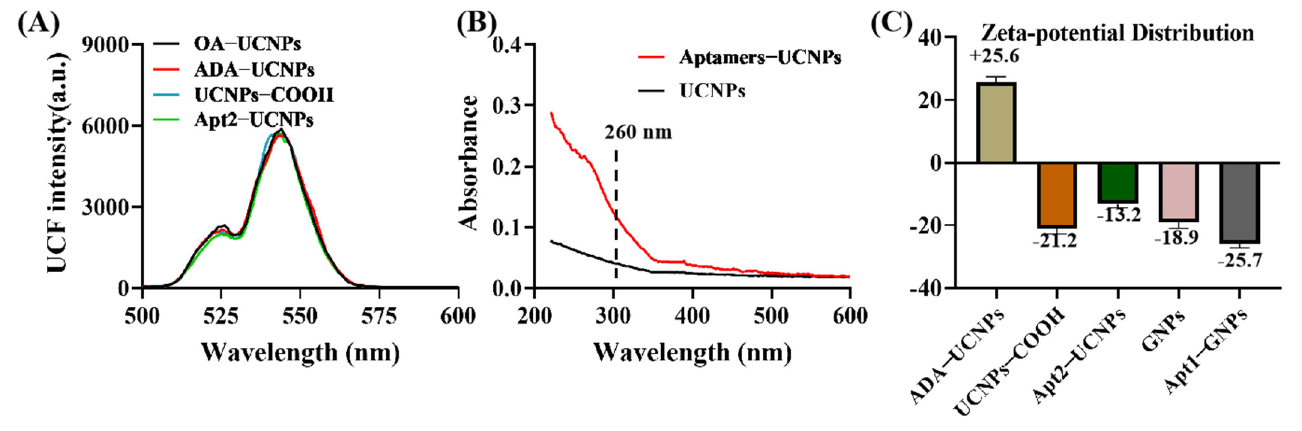
Figure 5. UV-Vis spectra of the UCNPs − COOH before and after aptamers modification ( A ); fluores- cence spectra of OA − UCNPs, ADA − UCNPs, UCNPs − COOH, and apt1 − UCNPs ( B ); zeta-potential of ADA − UCNPs, UCNPs − COOH and apt2 − UCNPs, GNPs, and apt1 − GNPs ( C ).